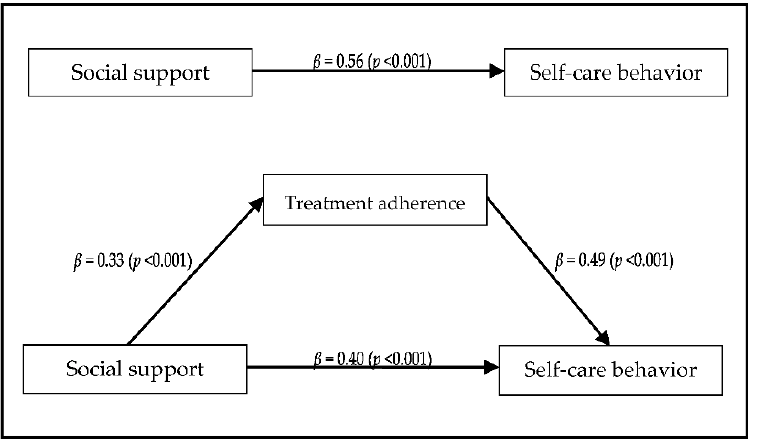
Figure 1. Mediating effect of treatment adherence on the relationship between social support and self-care behavior.